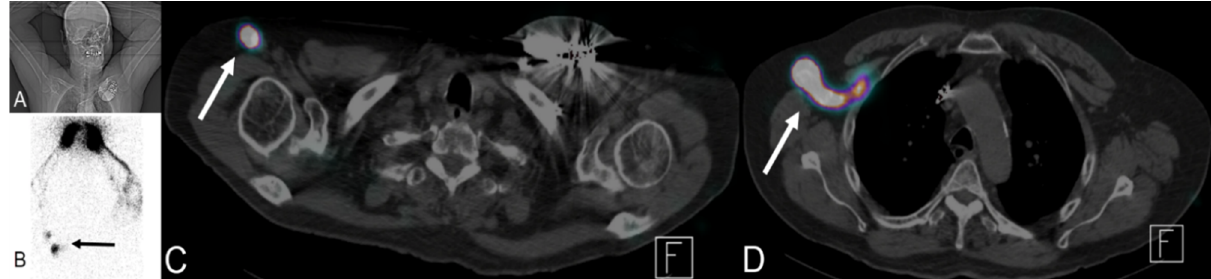
Figure 17. A 68-year-old male with melanoma in the right temporal region who underwent lym- phoscintigraphy ( A ) and complementary SPECT/CT scan in the coronal plane ( B ); ( C , D ) show CT (left) and fused SPECT/CT images (right) for sentinel lymph nodes mapping. Intradermal injection of the TC 99m sulfur colloid in the right temple (arrow in B) shows tracer uptake in the pre-auricular region (arrowhead in C ) and intra-parotid region (arrowhead in D ), consistent with sentinel lymph drainage.